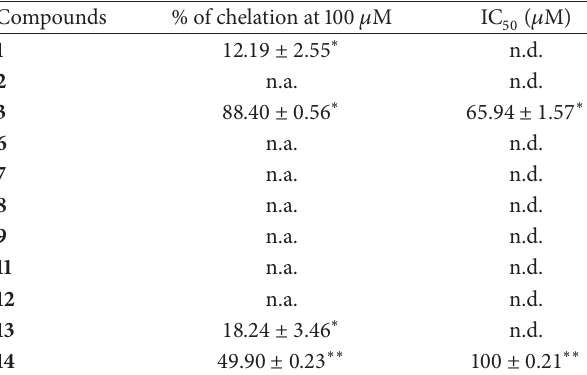
Table 2: Iron chelating activity of tested compounds.